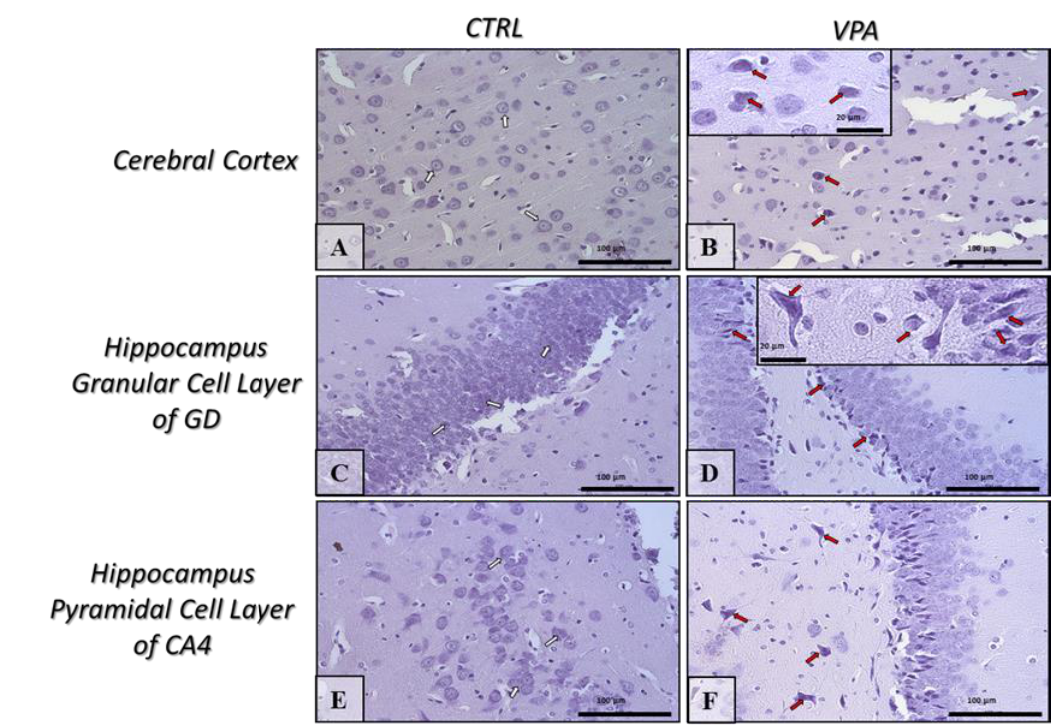
Figure 16. The effect of prenatal exposure to VPA on the histopathological changes in the neurons of the rat brain. Representative microphotography showing the histological structure of chosen brain regions (hippocampus and cerebral cortex) in control ( A , C , E ) and VPA-exposed rats ( B , D , F ). H&E staining. Scale bar: 100 µm and 20 µm in the insertion of B and D (objective magnification ×40, ×100, respectively). White arrows—normal nerve cells, red arrows—neurons that shown chromatolysis (acidophilic degradation of Nissl bodies and pyknotic nucleus). Representative pictures from n = 11 (CTRL) and n = 9 (VPA) independent experiments in both the hippocampus and cerebral cortex are presented.